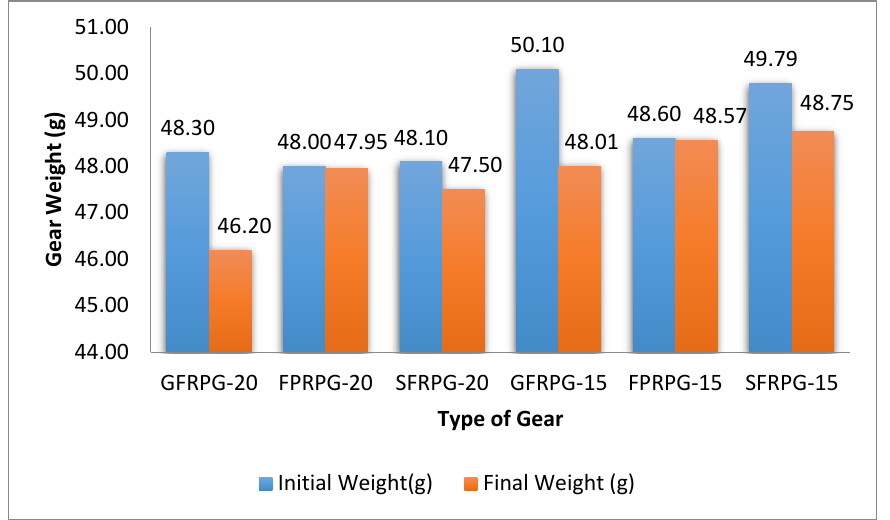
Figure 6. Comparision of initial and final weights of all the gears.